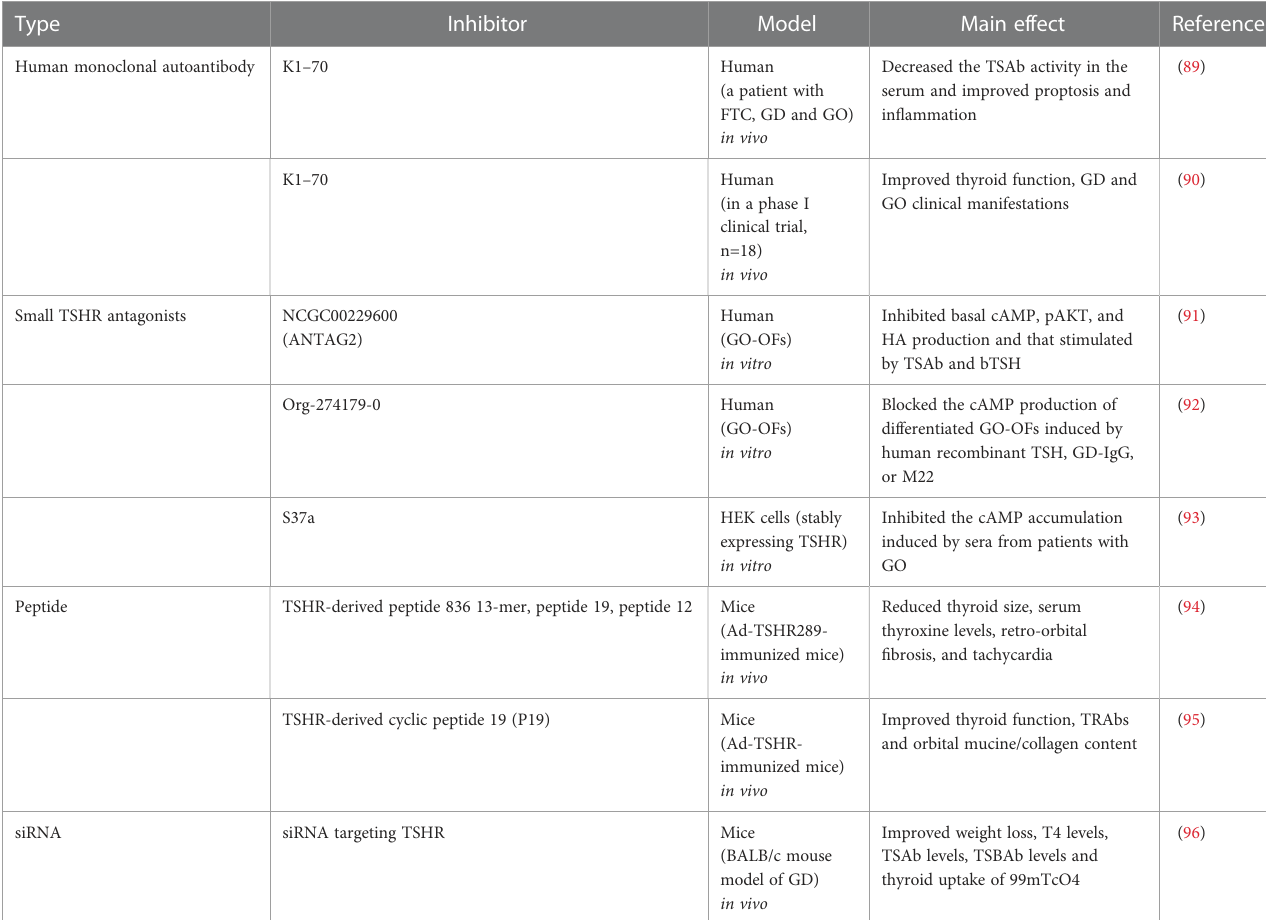
TABLE 1 Potential novel therapies for GO that directly target